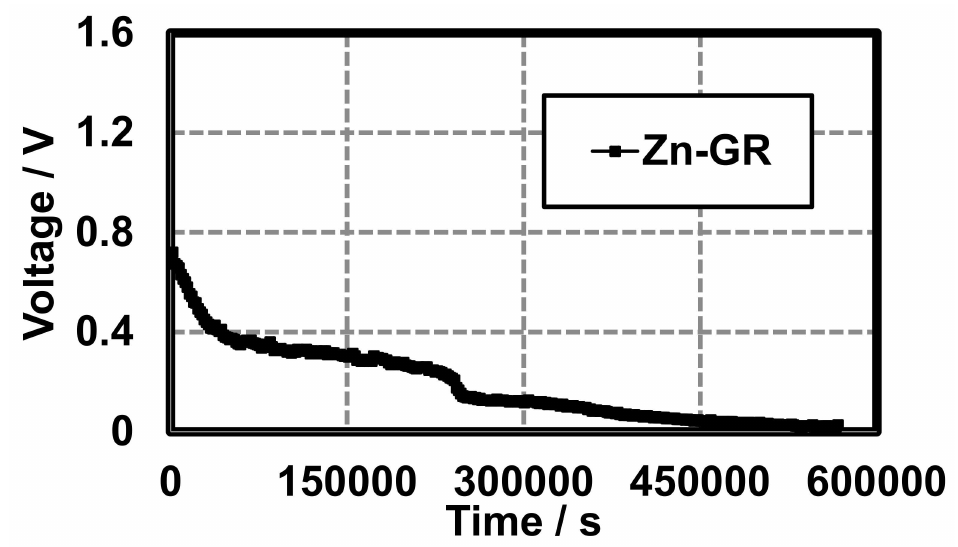
Figure 5. Gel Leclanch é cell continuous discharge data across a 10 k Ω resistor with GR as the conductive additive. Average of three trials.